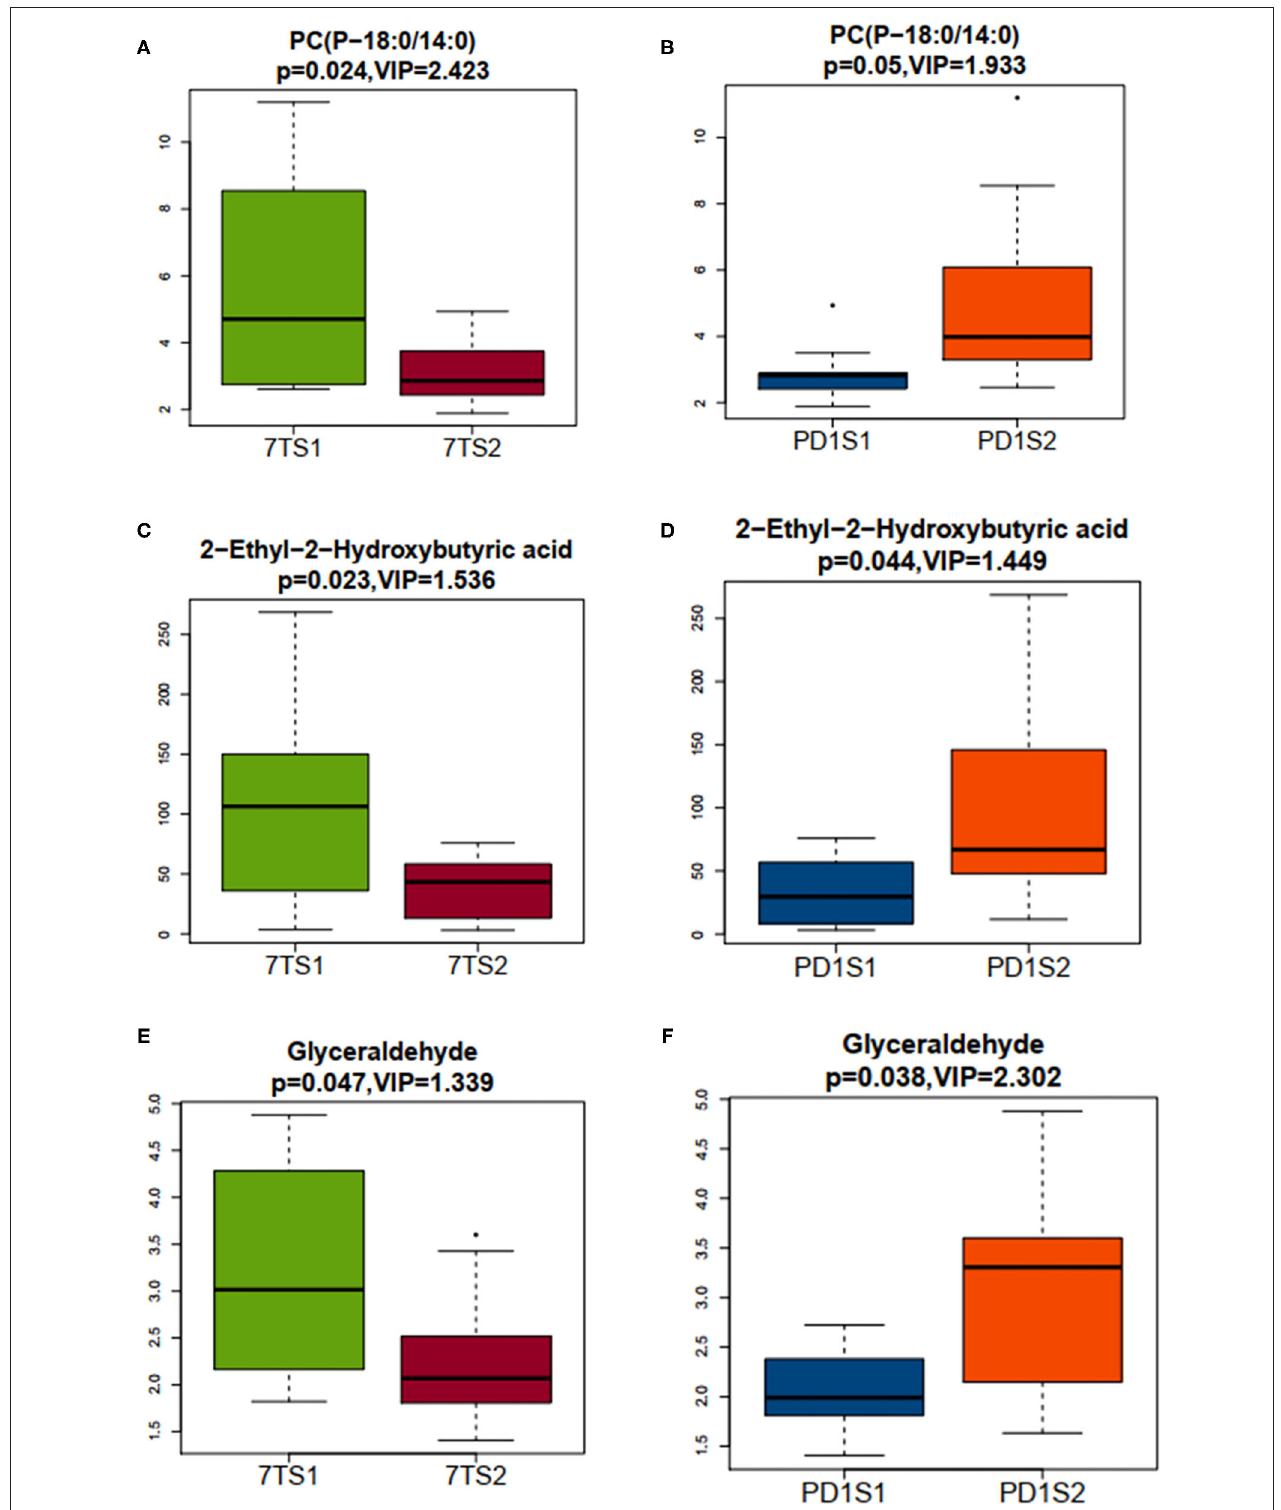
FIGURE 4 | The abscissa represents the sample grouping, 7TS1 and 7TS2 represent the 7-day death group and survival group, respectively, PDS1 and PDS2 represent the high PD-1 and low PD-1 expression groups, respectively, the ordinate represents the expression of the screened differential metabolites, the box